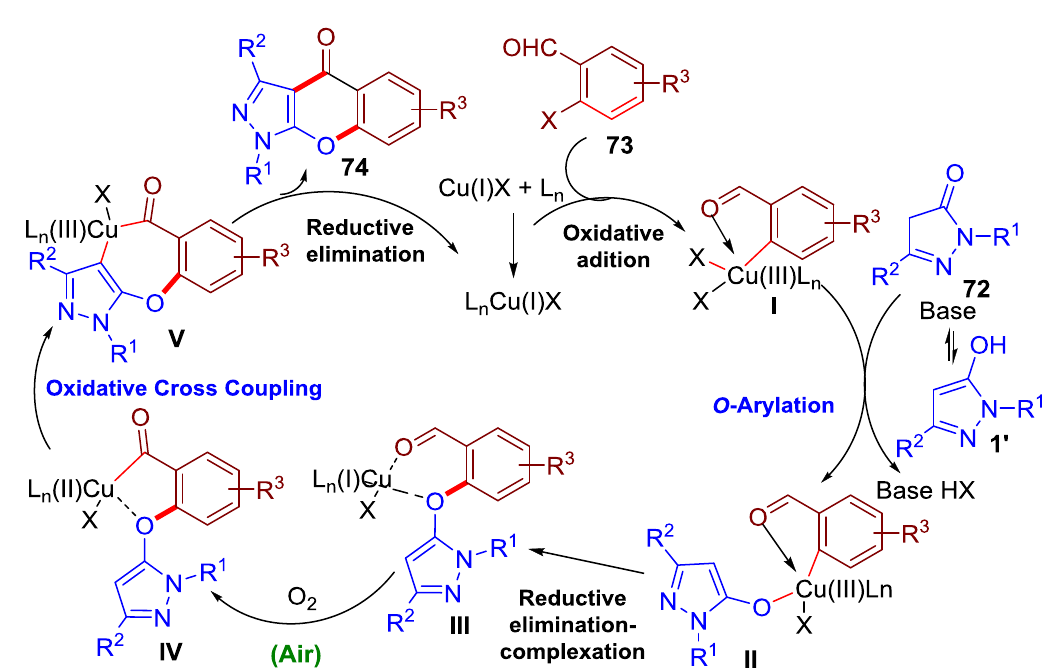
Scheme 22. Plausible mechanism of the tandem O -arylation-oxidative coupling between 2-pyrazolin-5-ones 72 and o -haloarylaldehydes 73 [52].